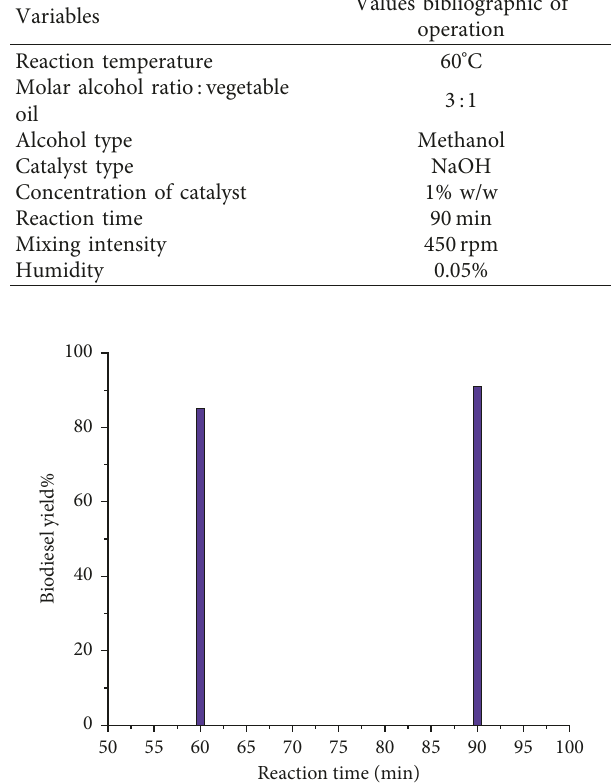
Table 3: The rate of raw material input into the process is 4759 kg per hour [13]. In comparison, the process output is 3909 kg/h, resulting from the steam currents and biodiesel from Table 4, with an 83% w/w conversion using ZrO 2 .